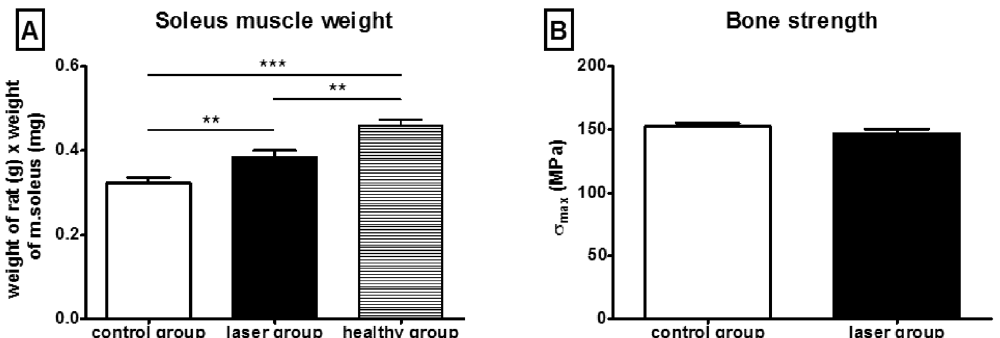
Figure 3. Effect of laser treatment on soleus muscle weight and bone strength. ( A ) Soleus muscles were dissected and weighed immediately after the perfusion. The weight of soleus muscle of laser-treated animals was significantly higher compared to control animals. ( B ) The three-point bending test was used to evaluate mechanical properties of rat femurs. There were no significant differences between groups. The values are expressed as mean ± SEM. Control group n = 11, laser-treated group n = 15, healthy group n = 8. * p <